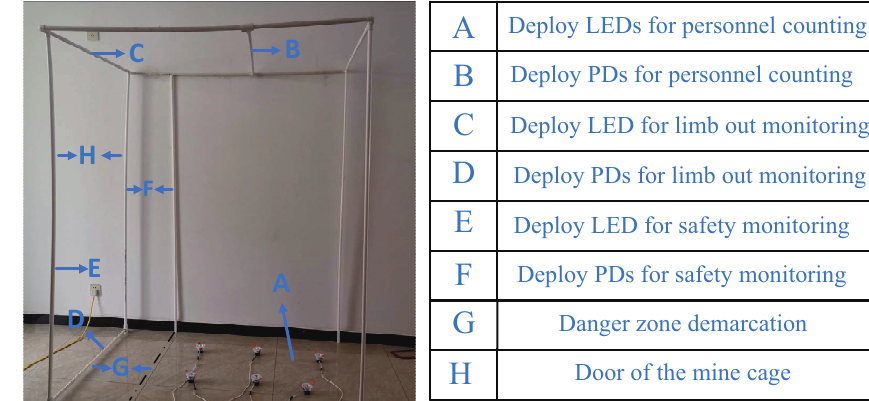
Figure 10. Mine cage model.